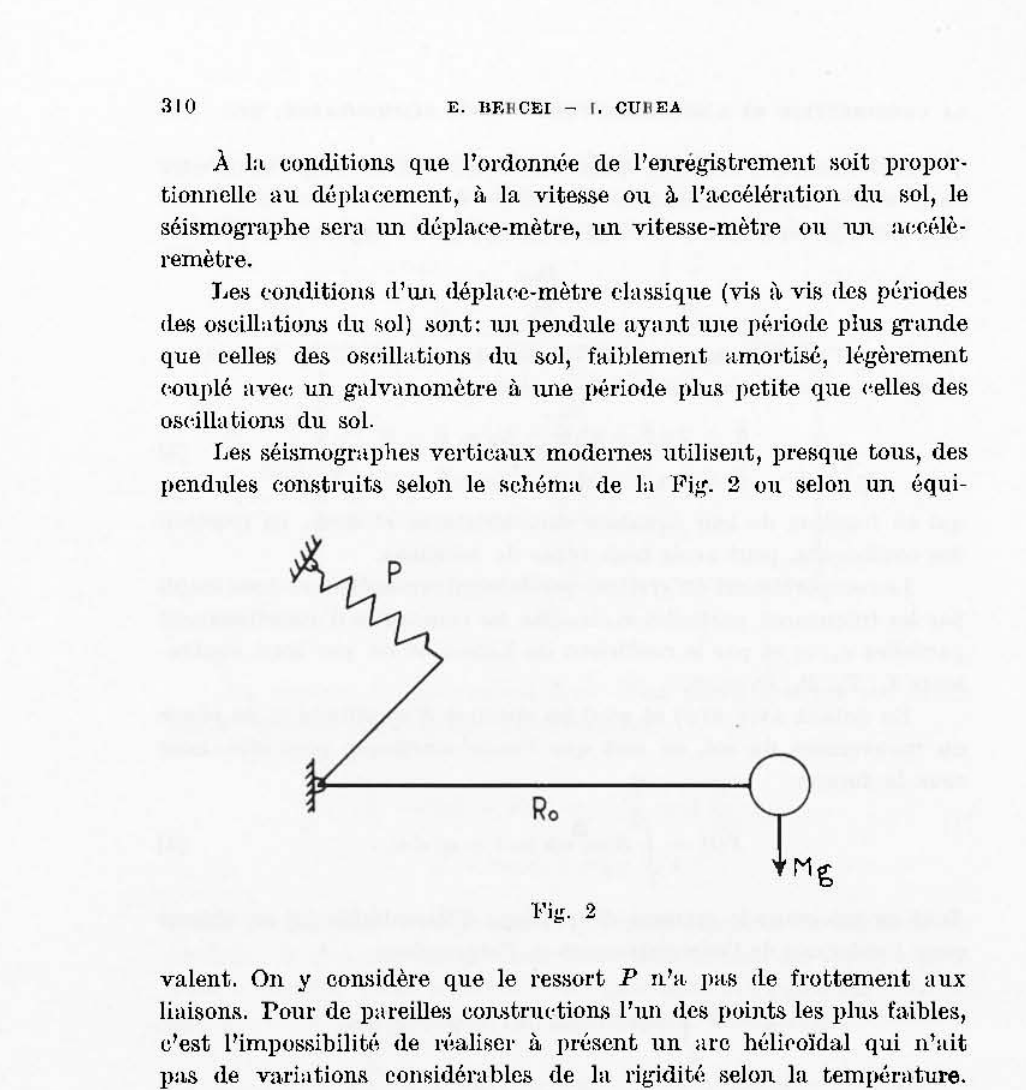
référenee. On obtient: où O" est la rif,riditè du ressorL